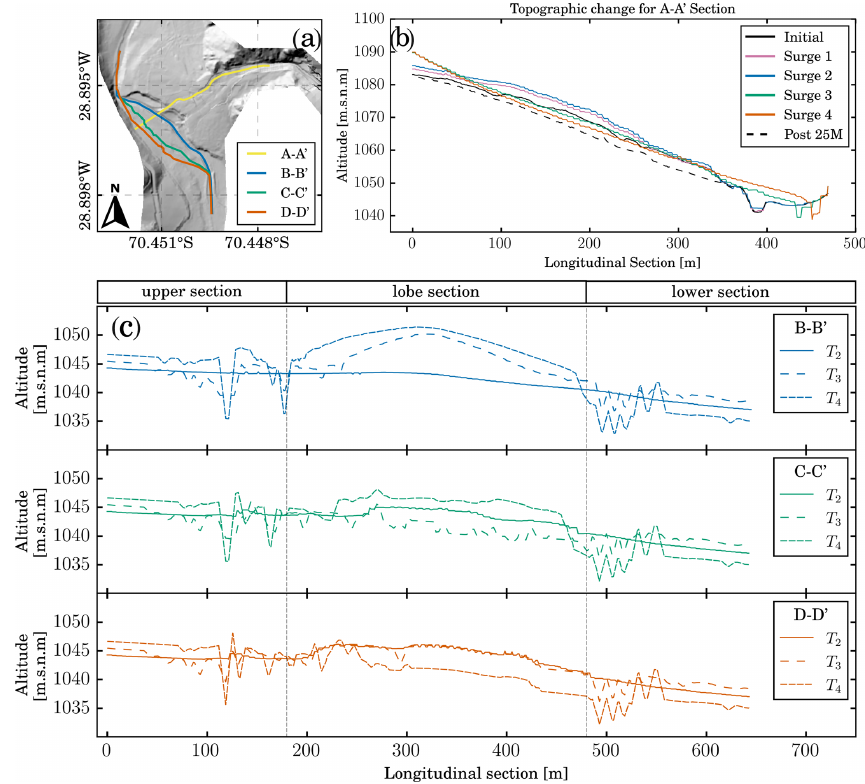
Figure 7. Morphological evolution of the tributary-junction alluvial fan. (a) Location of the longitudinal sections presented in (b) and (c) . (b) Longitudinal profile A-A’ of the alluvial fan topography after each surge. (c) Longitudinal profiles B-B’, C-C’, and D-D’ of the river’s topographic